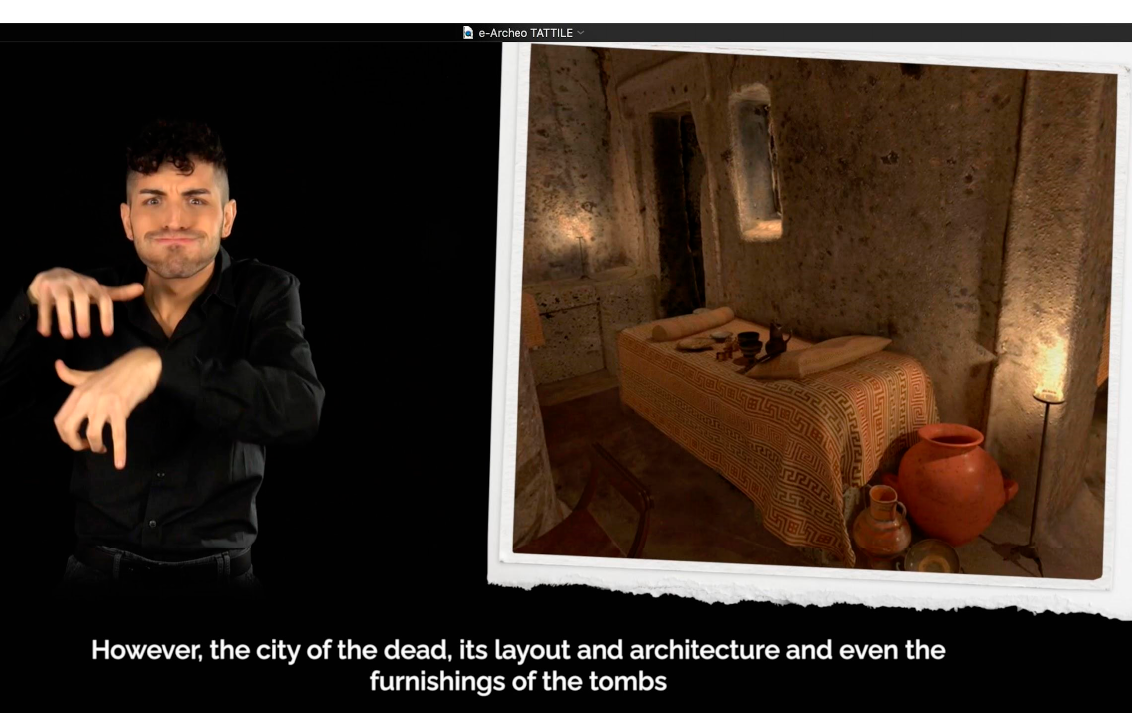
Figure 8. e-Archeo Tactile, accessible installation in Sala Mengarelli in Cerveteri, IS interpreter and his gestural expressiveness.